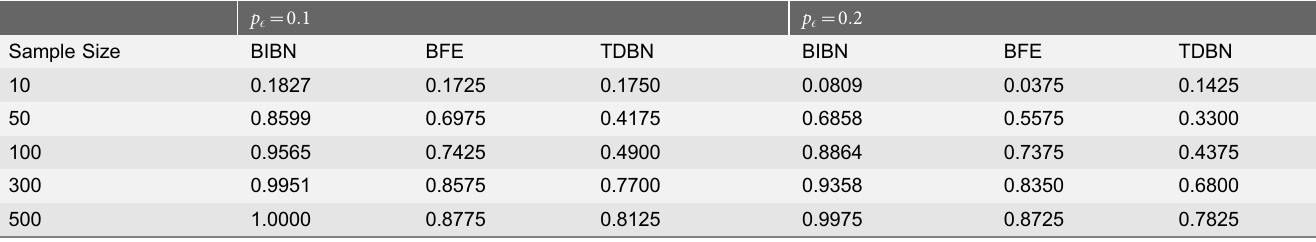
Table 2. Average accuracy comparisons on the synthesized